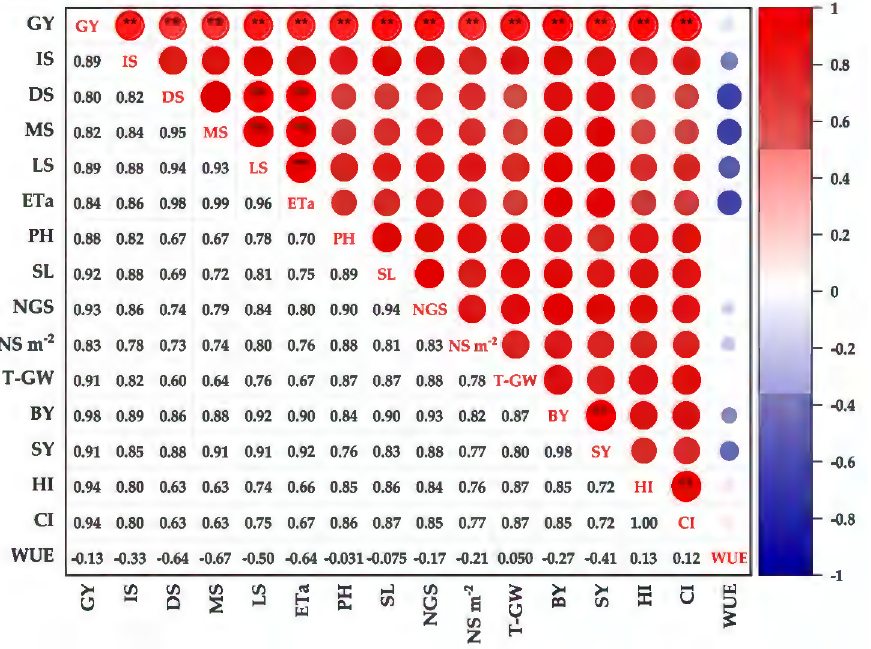
Figure 8. Matrix of Pearson’s correlation coefficients and correlation plots for studied traits. Pearson’s correlation coefficients are presented in the bottom − left half. The correlation plots are presented in the upper right half. The colours of the cells exhibit positive or negative correlations based on the colour scale. ** represent significance at 0.01. Grain yield (GY), ETa at initial stage (IS), ETa at development stage (DS), ETa at mid − stage (MS), ETa at late stage (LS), actual evapotranspiration (ETa), plant height (PH), spike length (SL), number of grains spike − 1 (NGS), number of spikes m − 2 (NS m − 2 ), 1000 − grain weight (T − GW), biological yield (BY), straw yield (SY), harvest index (HI), crop index (CI), water use efficiency